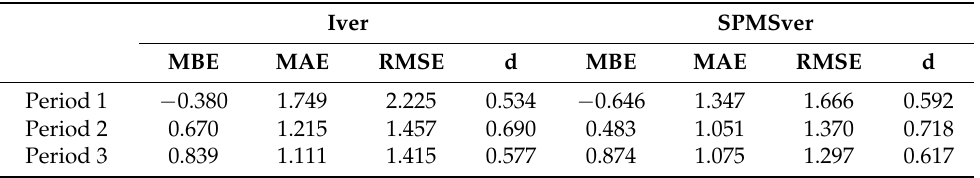
Table 1. Median values of MBE, MAE, RMSE and d for the Iver and SPMSver and the three meteorological periods regarding wind speed (ms − 1